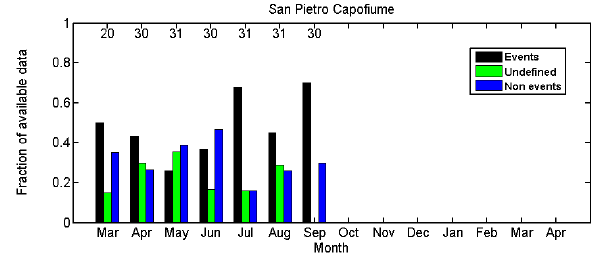
Fig. A11. The fraction of event, undefined and non-event days out of all analyzed days during each month in the year at San Pietro Capofiume, Italy, during March–September 2008.